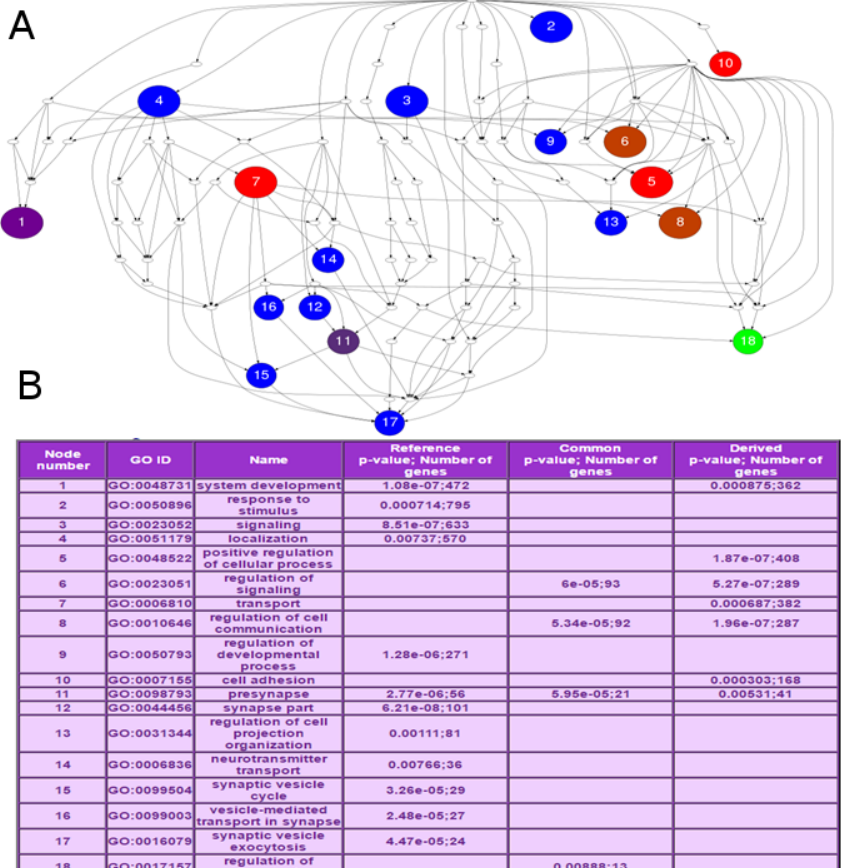
Figure 4: A Gene Ontology graph for C->T mutation at seed position 7 of hsa-miR-615-5p. (A) The Gene Ontology figure in the example shows the distribution of enriched GO terms (with p -value <0.01) in the GO hierarchy by varying the node colors for the enriched terms from reference targets, derived targets and common targets. Number of target genes for ref- erence targets), derived targets and common targets determine the “ blue ” , “ green ” and “ red ” components of nodes color respectively. The node colors are varied for changes in the number of targets to form the color triangle (for details see the HELP page of miR2GO, http://compbio.uthsc.edu/miR2GO/help_GO.php). (B) The Gene Ontology ID and name for each node in